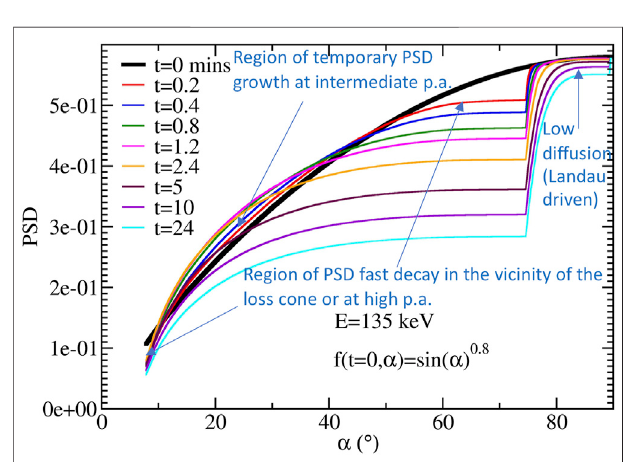
FIGURE 8 | Phase space density of 135 keV electrons versus pitch angle for different times (in min) with four pitch angle regions of different dynamics that are indicated with